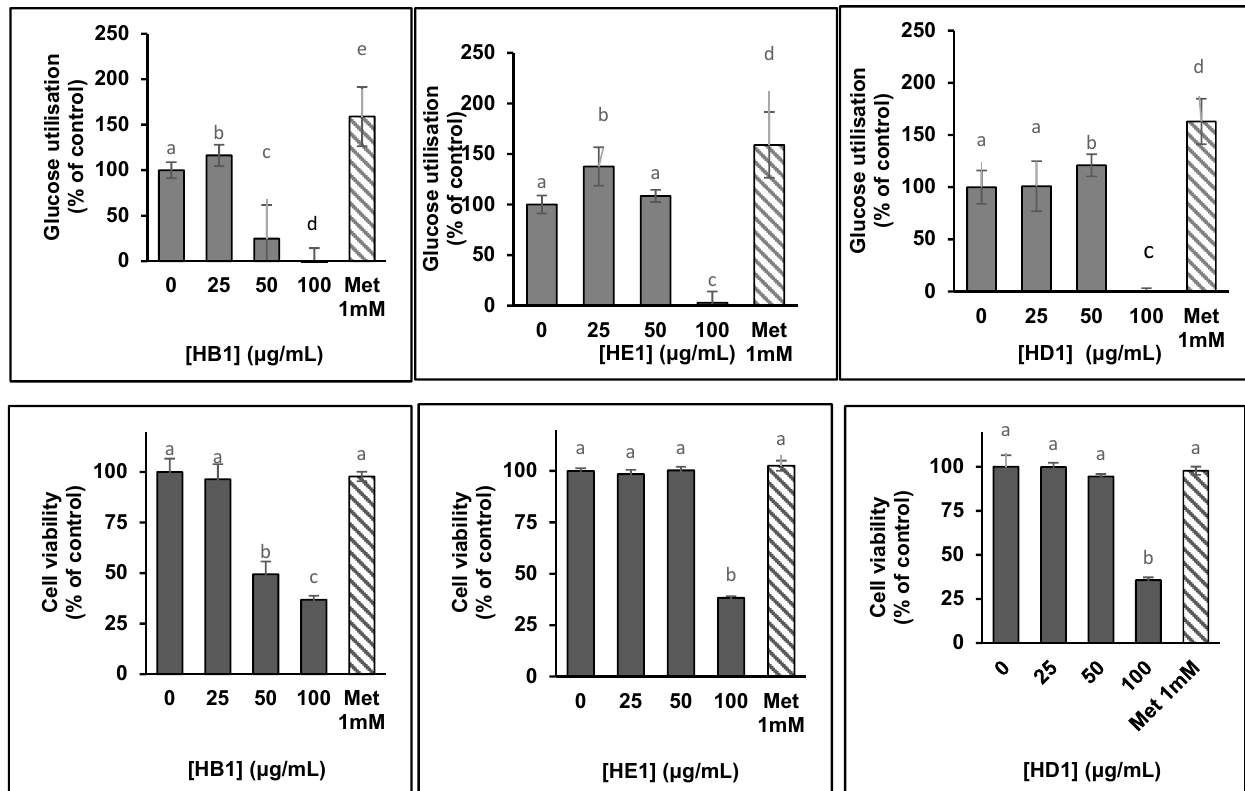
Figure 7. Effects of H. arborescens leaf extracts on glucose utilization in C3A cells and their corresponding effects on the C3A cell viability (MTT cytotoxicity) compared to the untreated cells. (Data are expressed as % of control ± SD, n = 3). HB—Blanched; HE—Ethanol and HD—Aqueous extracts; Met—Metformin. Mean separation by SD ( p < 0.05). Set of bars with different alphabets are significantly